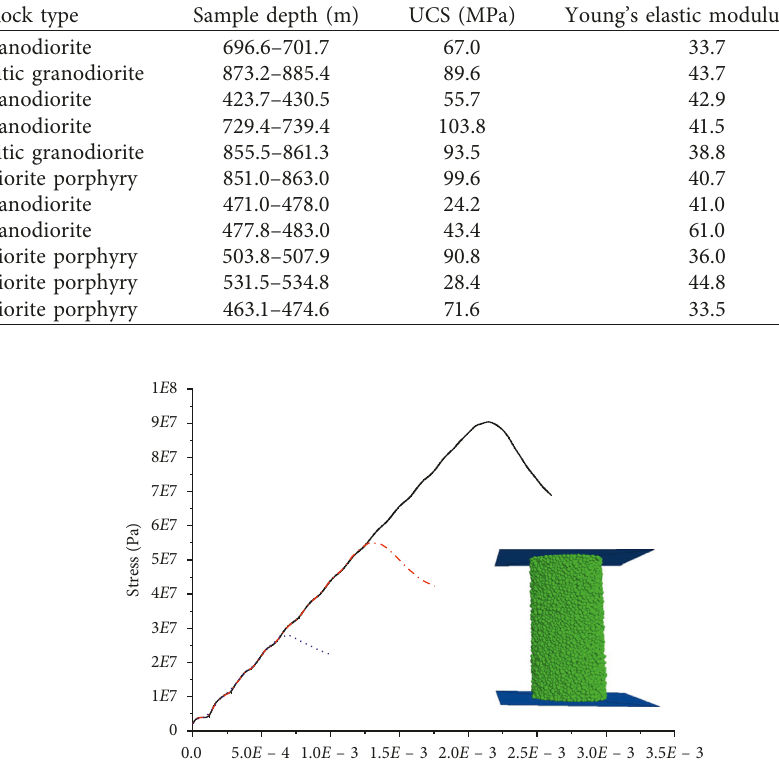
Table 1: The mechanical properties of different rock